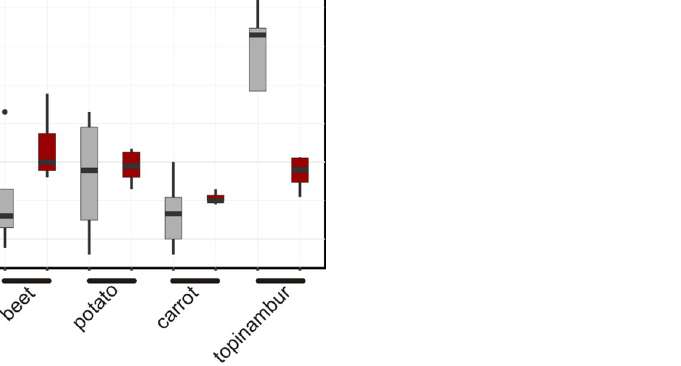
Fig 6. Median CFU counts of cultivated bacteria. Dilutions of the melted samples for CFU counting were plated on both R2A agar and FAA and incubated for one week at room temperature.